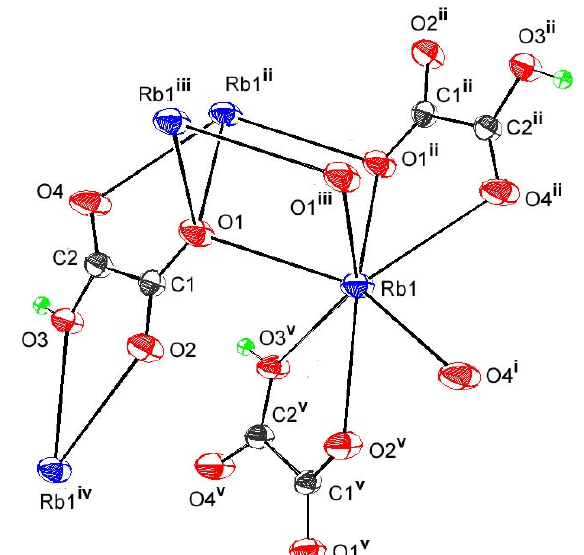
are drawn with 50%